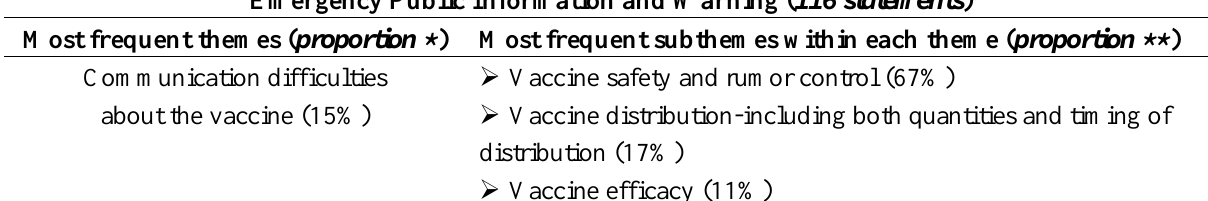
Table 1. Analysis of themes and sub-themes for the capability of emergency public information and